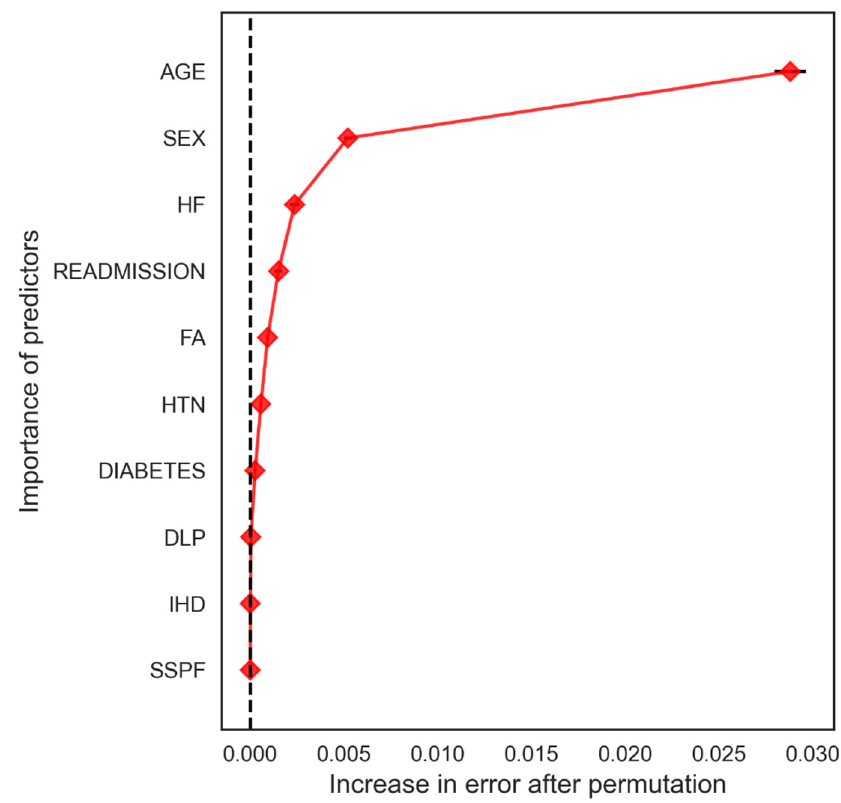
Figure 7. Permutation test. Correction of predictors after permutation. Table 5. Results of the different metrics according to the method of analysis.